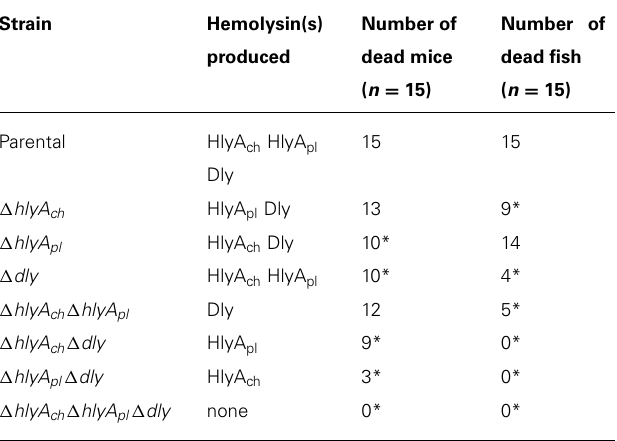
Table 1 | Role of the three Photobacterium damselae subsp. damselae hemolysins in virulence for mice and fish (turbot).